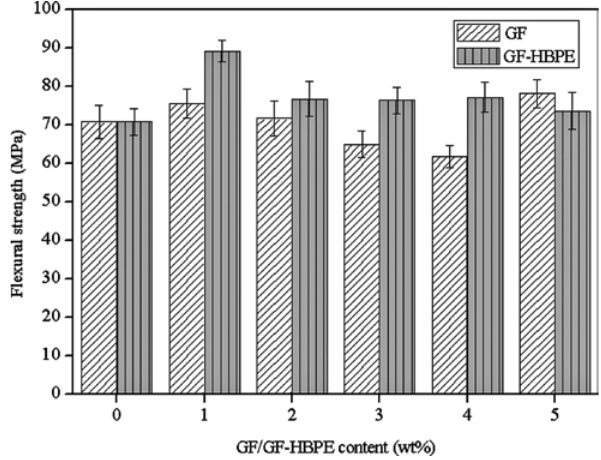
Figure 8: Flexural strength of epoxy composites.